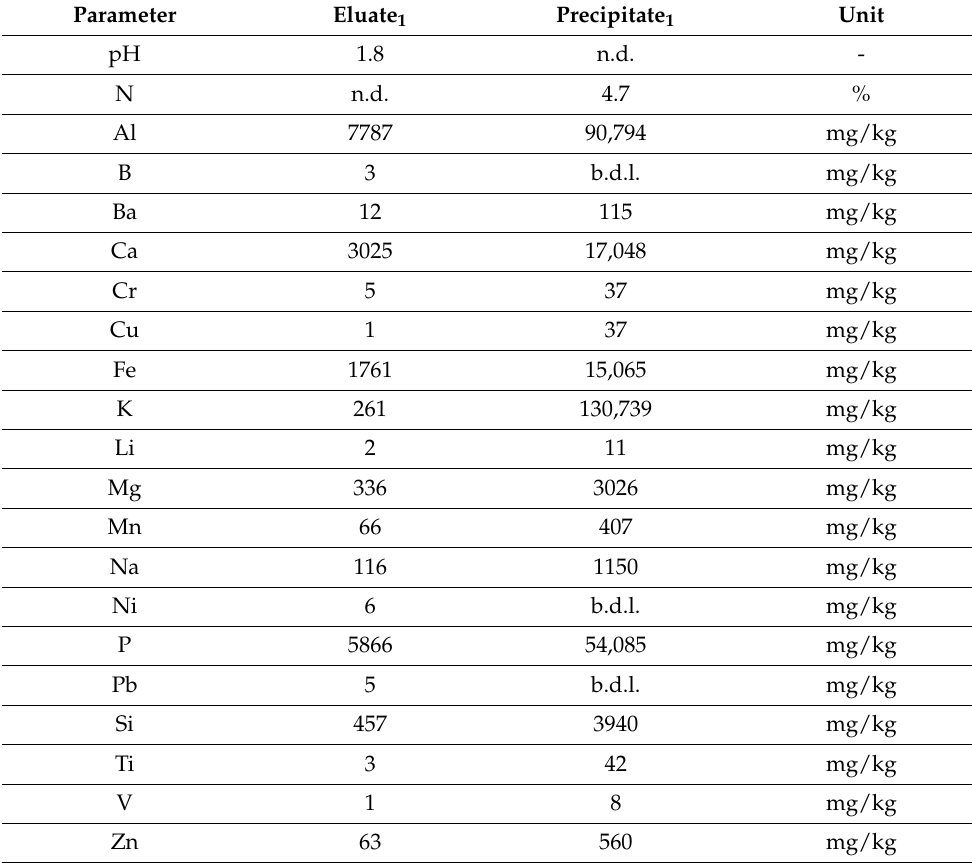
Table 12. Characterization of case 1 eluate (eluate 1 ) and precipitated inorganic product (precipitate 1 ). Parameter Eluate 1 Precipitate